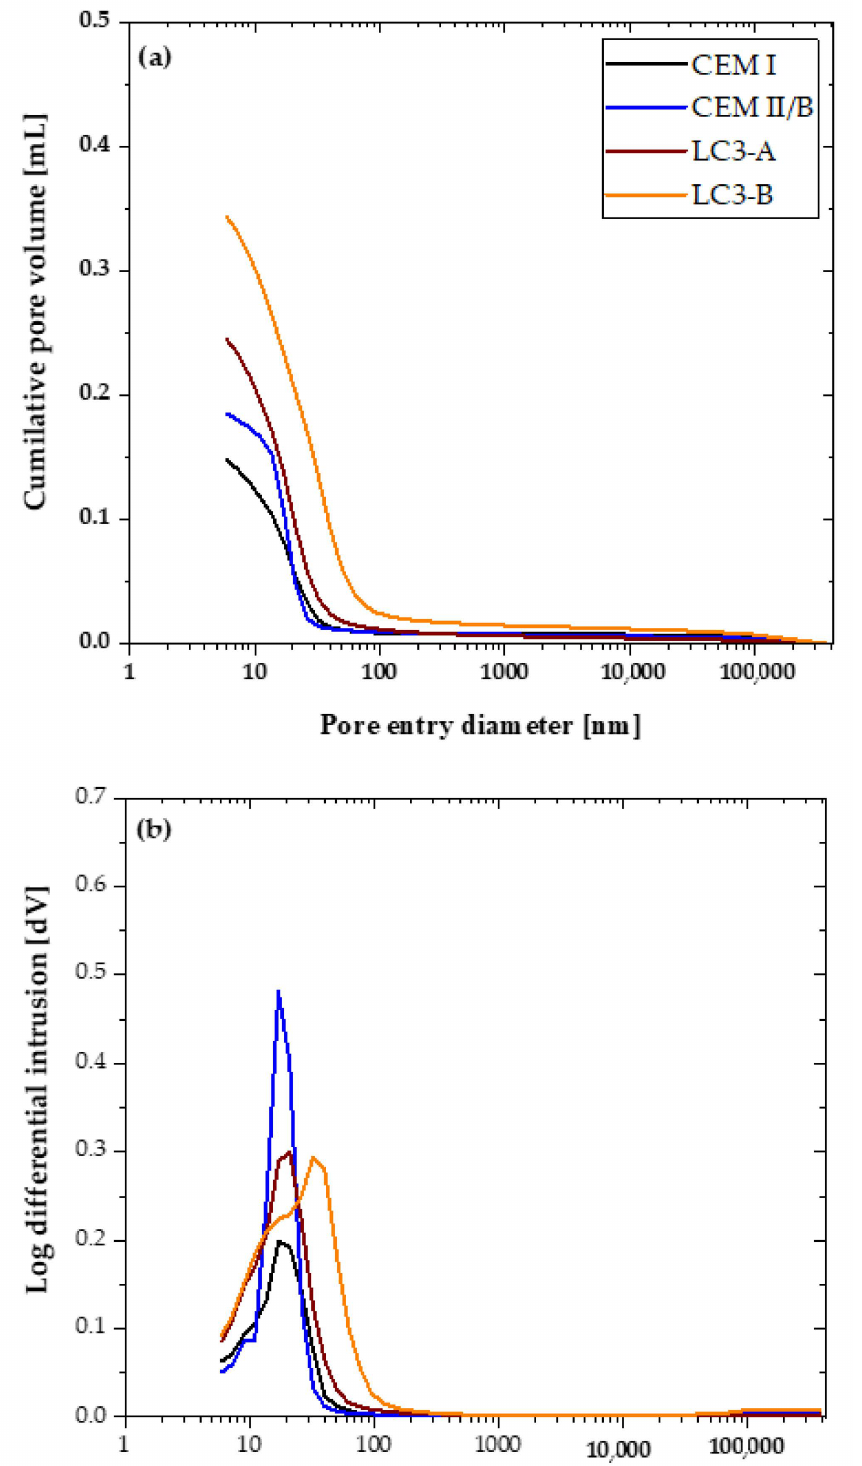
Figure 13. Pore structure distribution of each sample ( a ) total intrusion curve, and ( b ) differential intrusion